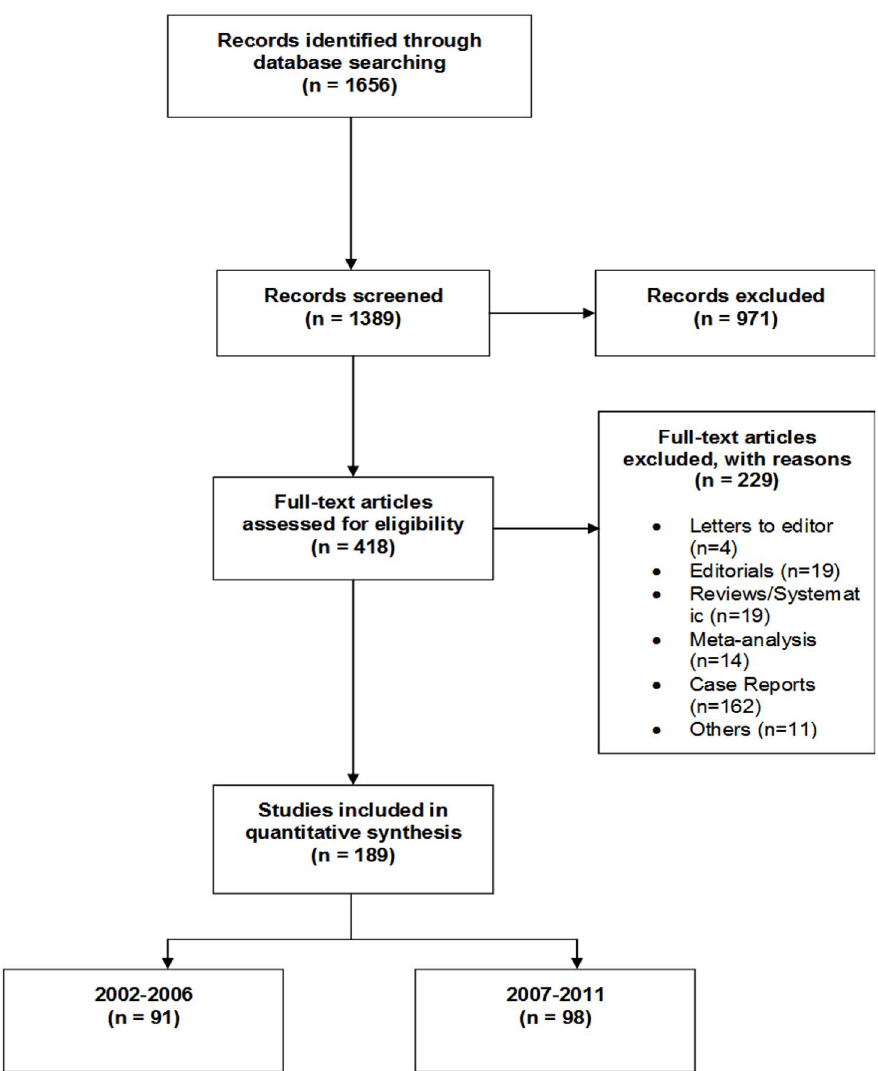
Figure 1. Flow chart showing the selection process of articles and the number in each period.